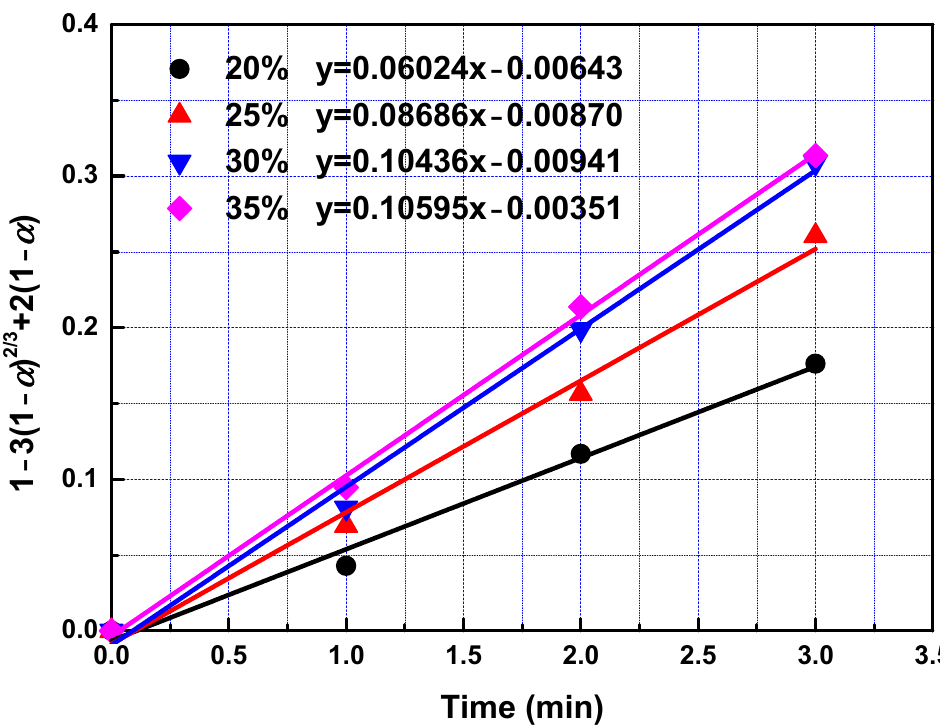
Figure 6. The relationship between 1 − 3(1 − α ) 2/3 + 2(1 − α ) and leaching time during the fast reaction.